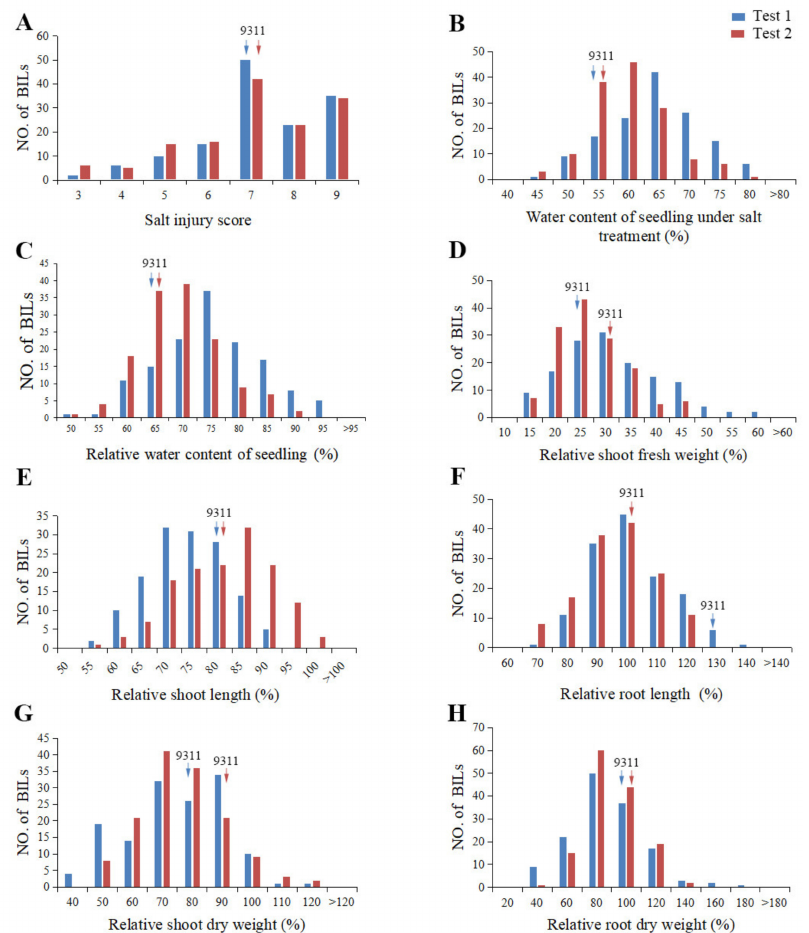
Figure 1. Frequency distribution of eight traits related to salinity tolerance of the 140 BILs seedlings. ( A ), the X -axis represents the salt injury score; ( B – H ), the X -axis represents the relative value of different traits, respectively. ( A – H ), the Y -axis shows the number of BILs. Arrows indicate the phenotypes of